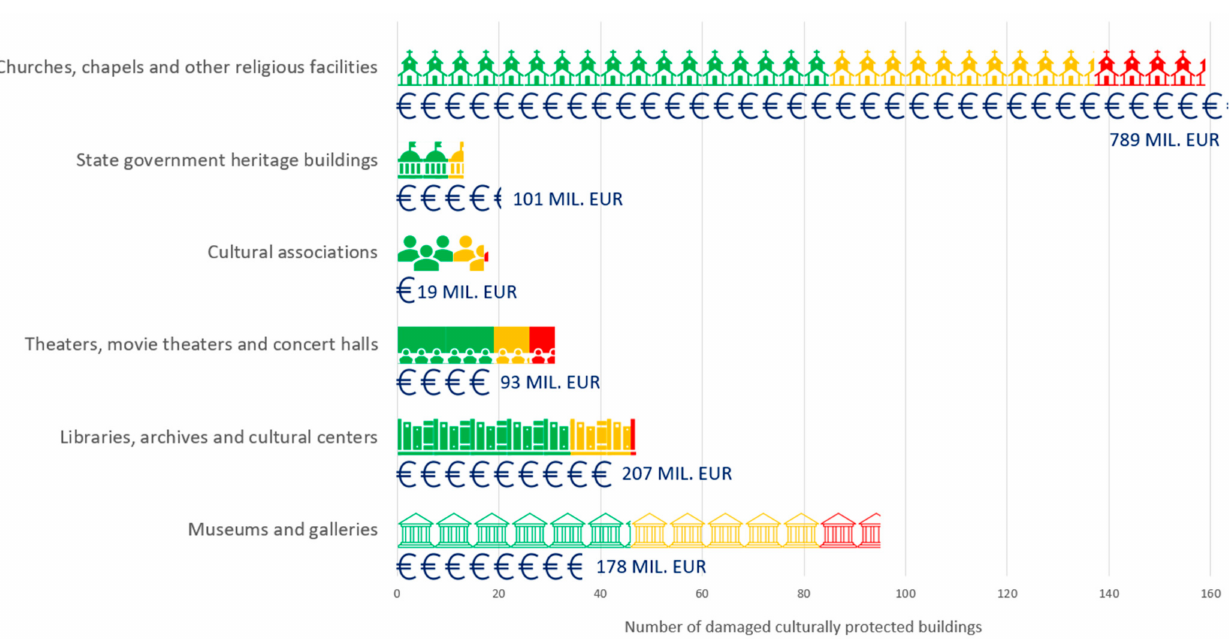
Figure 3. Damage to the heritage buildings after the Zagreb earthquake in